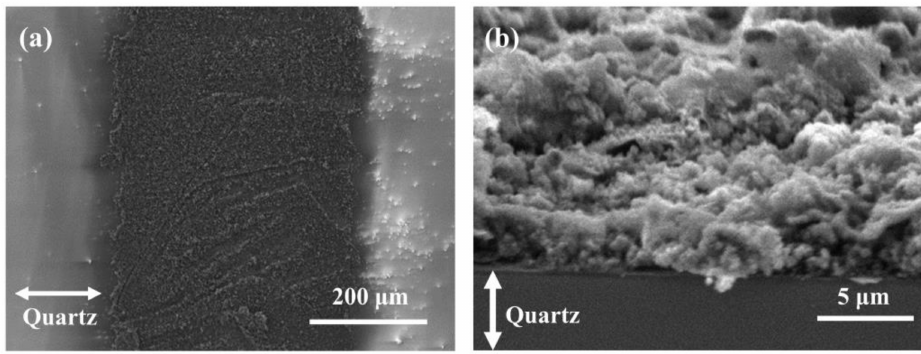
Figure 7. SEM images of Cu@LSC ( a ) in horizontal state and ( b ) tilted at 70 ◦ .